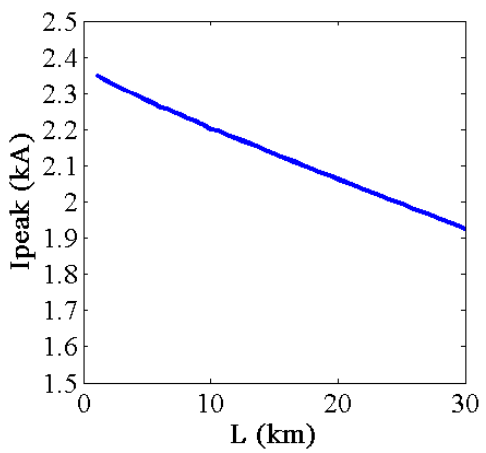
Figure 9. Peak currents of different fault positions.